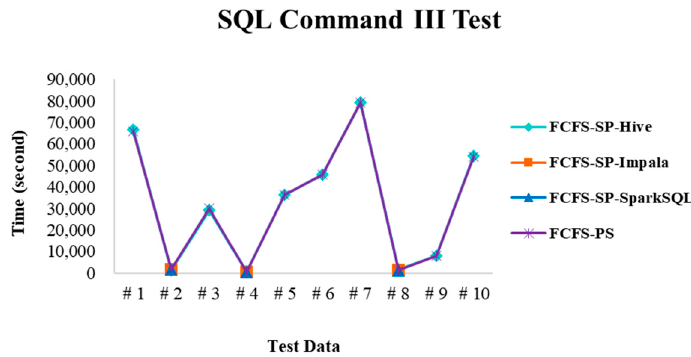
Figure 16. Execution time of SQL command II in test environment I.